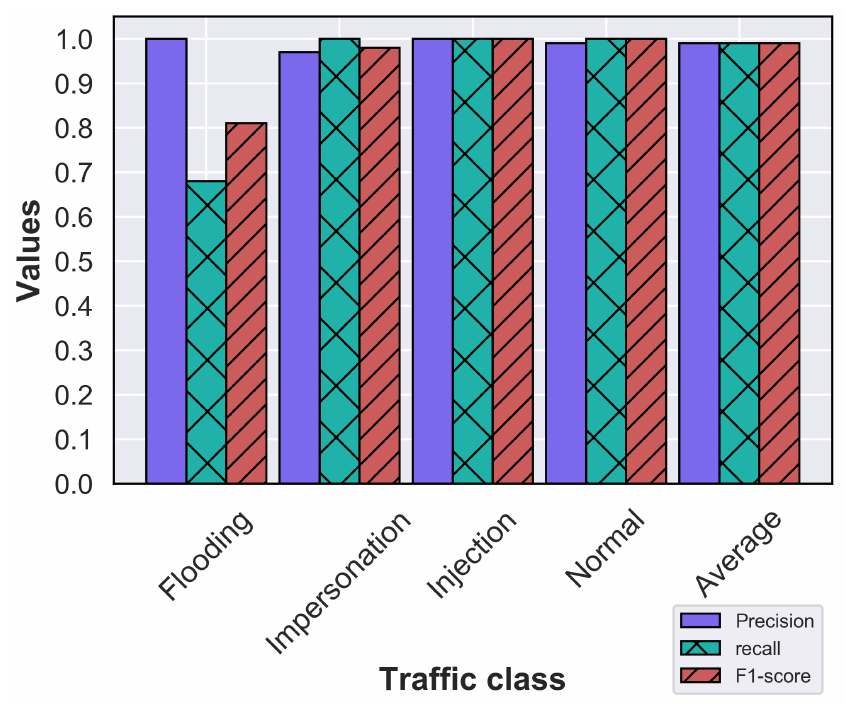
Figure 6. Performance metrics of the two-stage